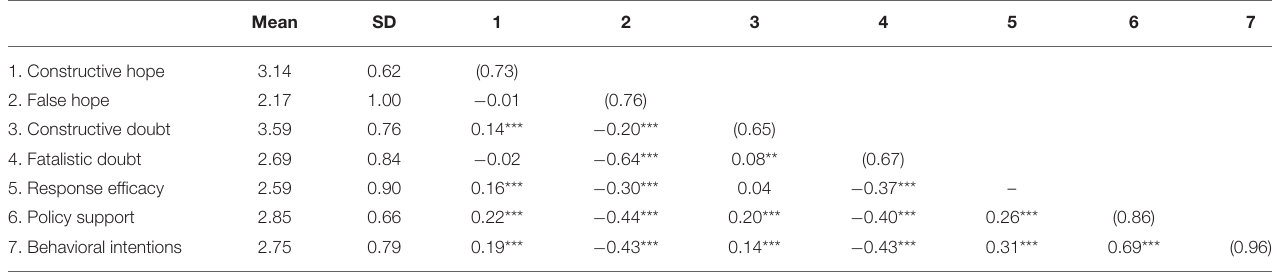
TABLE 4 | Study 2 correlation matrix ( N =